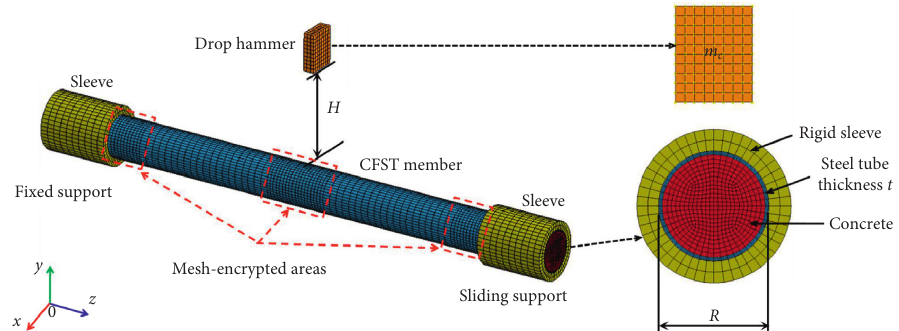
Figure 1: Finite element analysis model of the CFST